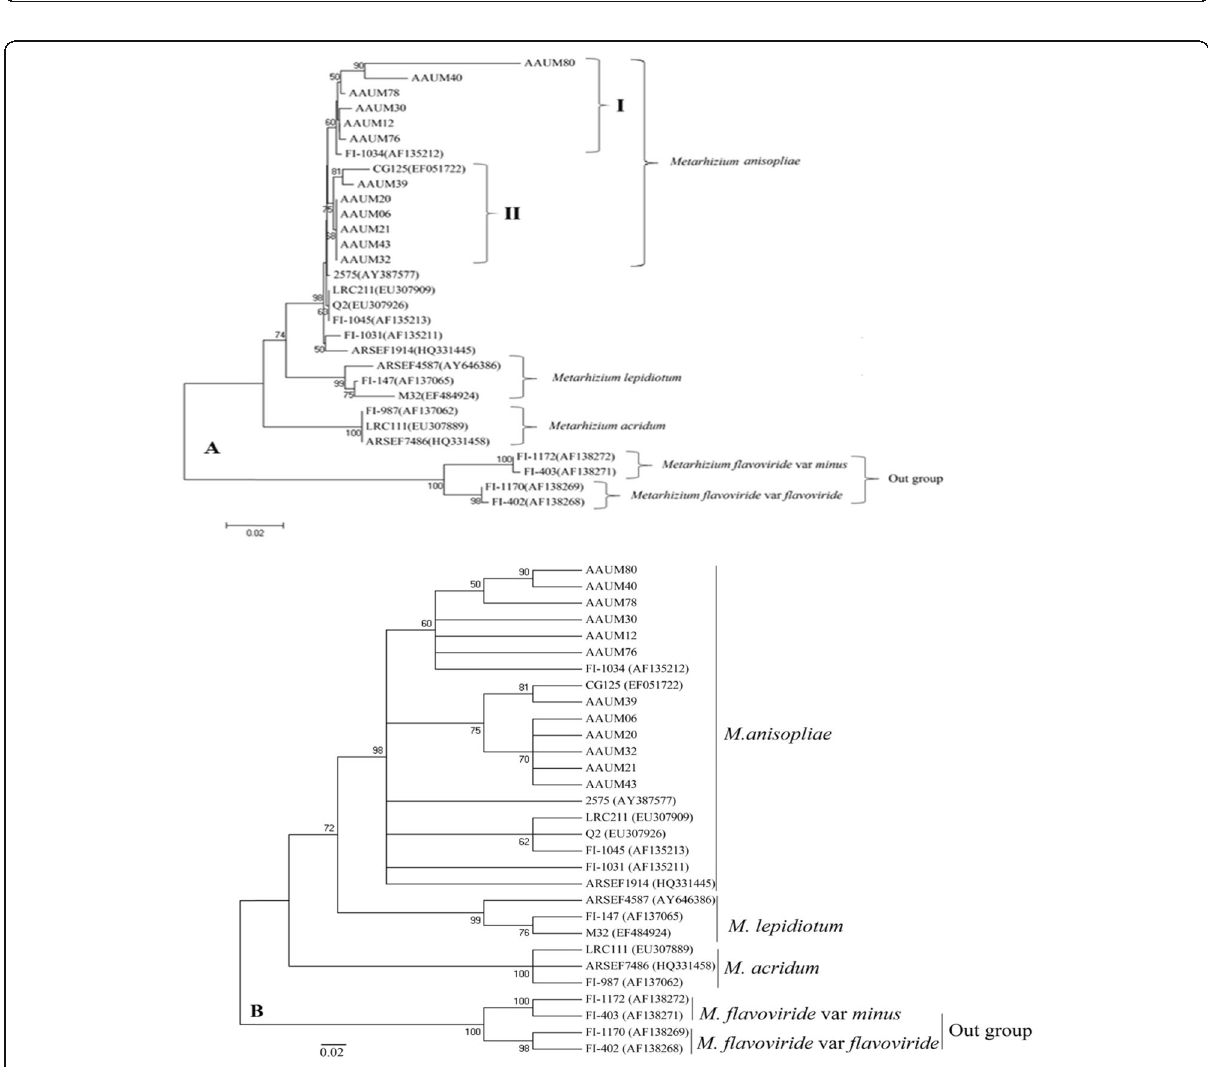
Fig. 4 Molecular phylogenic ( a ) and cladogram ( b ) analysis of ITS region of Metarhizium anisopliae from Ethiopia and other related sequences retrieved from gene Bank. Maximum likelihood phylogenetic tree (MEGA4.1) based on ITS sequences from Metarhizium species using K2þI model, with 1000 bootstrap replications. Bootstrap values above 50% shown and corresponding accession number of strains were presented in